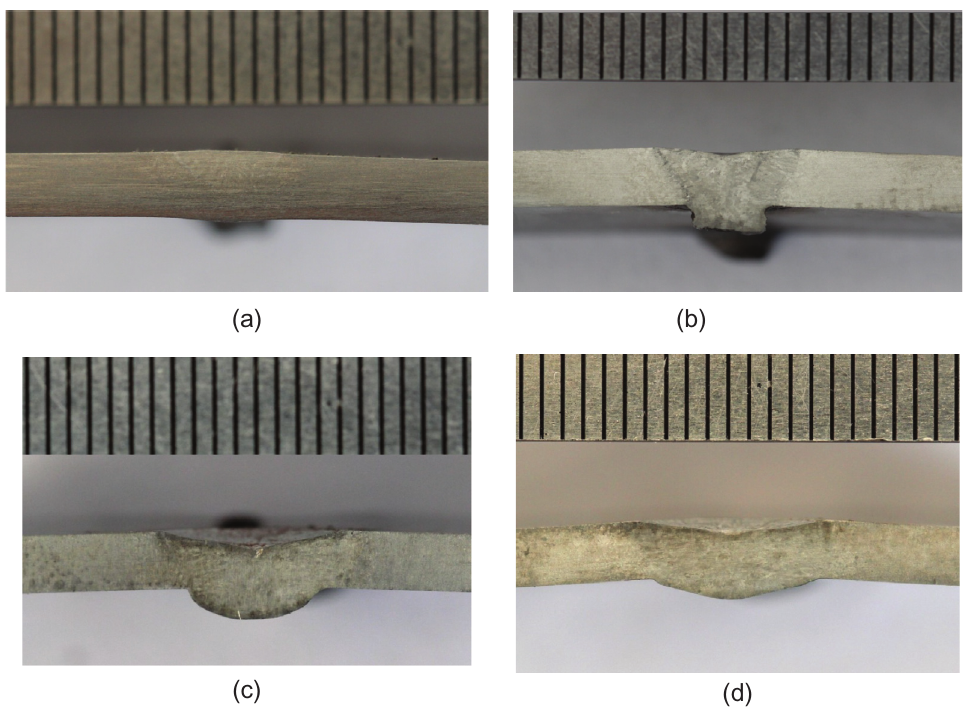
Figure 5: The macroscopic feature of weld pool (at different current (a) 50A; (b) 60A; (c) 70A; (d) 80A).